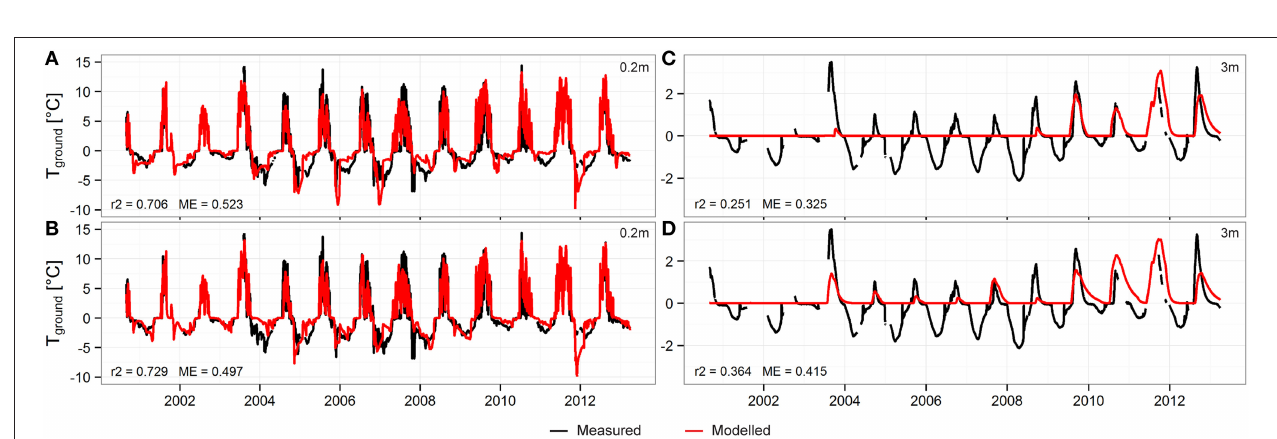
FIGURE 10 | Comparison of the COUP model semi-automated calibration of ground temperature before the manual adaptation of the wilting point (upper panel) and afterwards (lower panel). The calibration accuracy is tested at 20cm (A,B) and 3m depth (C,D) .